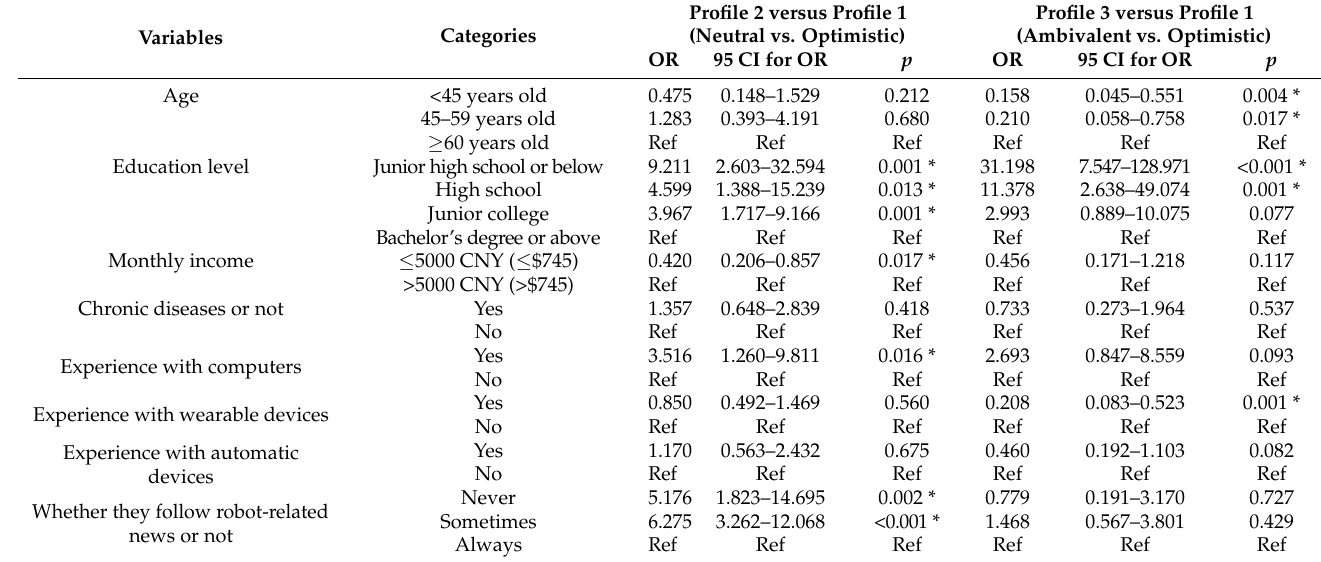
Table 4. Adjusted odds ratios related to members of Profiles 2 and 3 compared with Profile 1. Profile 2 versus Profile 1 Categories (Neutral vs.